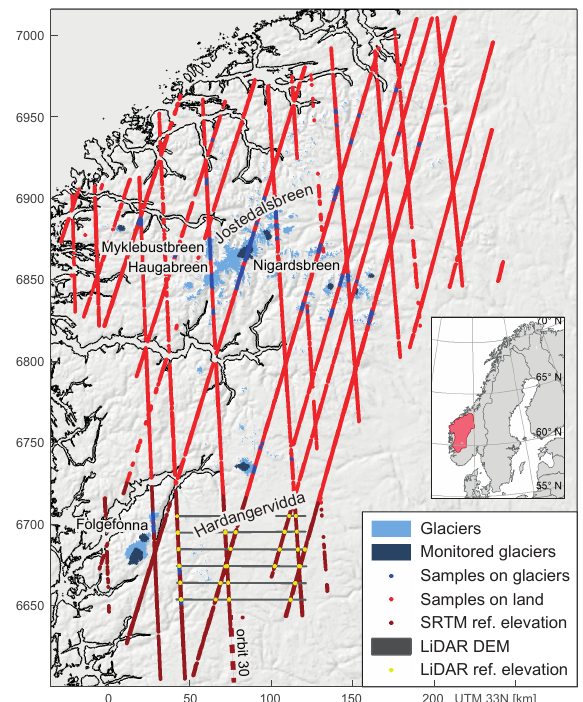
Figure 1. ICESat samples over glaciers and stable ground (land) in southern Norway. Only used footprints are displayed (no footprints on clouds or water). Glaciers with ongoing monitoring by NVE are